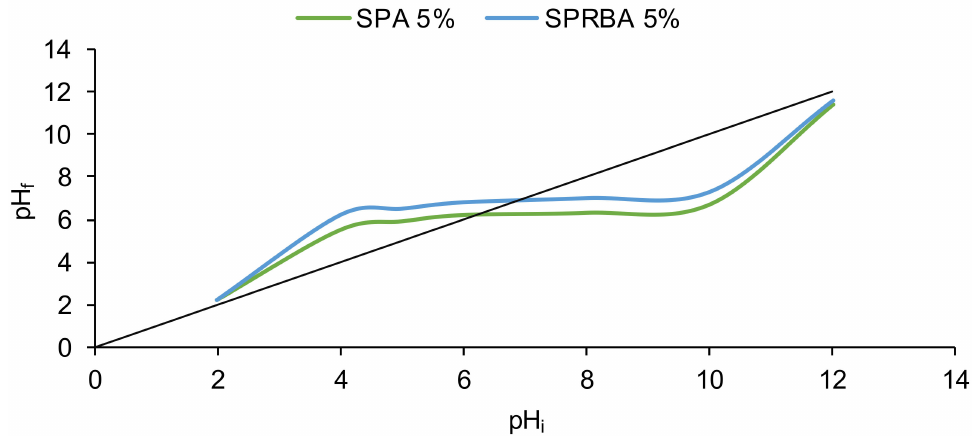
Figure 5. pH PZC of SPA 5% and SPRBA 5% biosorbents (pH f —final pH; pH i —initial